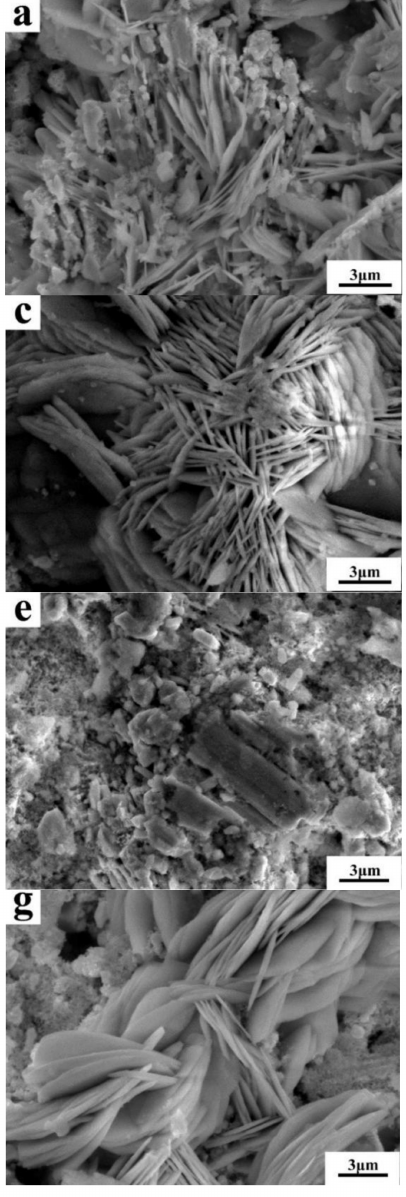
Figure 9. SEM of Sn-20Bi-xAl after polarized to 0 V in 3.5 wt.% NaCl solution: ( a , b ) Sn-20Bi, ( c , d ) Sn-20Bi-0.1Al, ( e , f ) Sn-20Bi-0.3Al, and ( g , h )